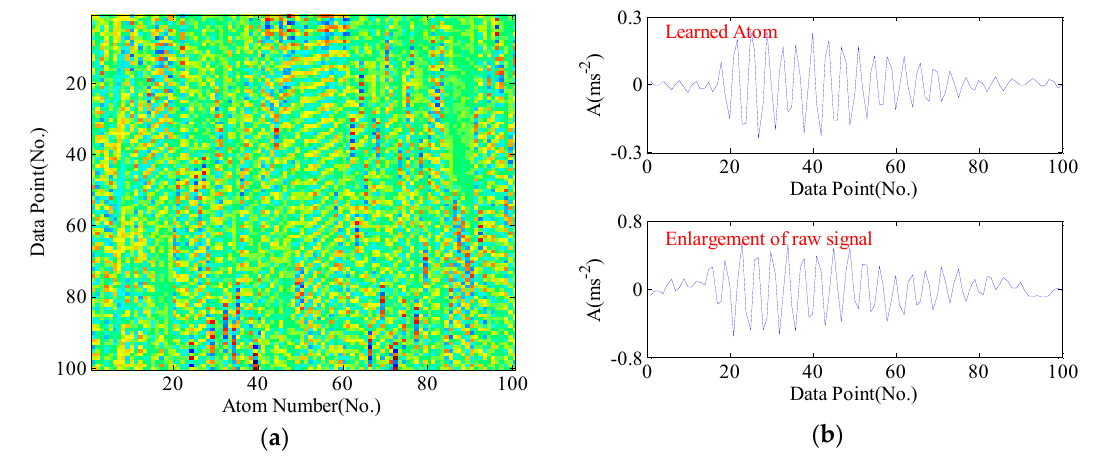
Figure 7. The learned dictionary from the sample signal of ball fault: ( a ) the learned dictionary matrix; ( b ) the learned atom and enlargement of the raw signal.